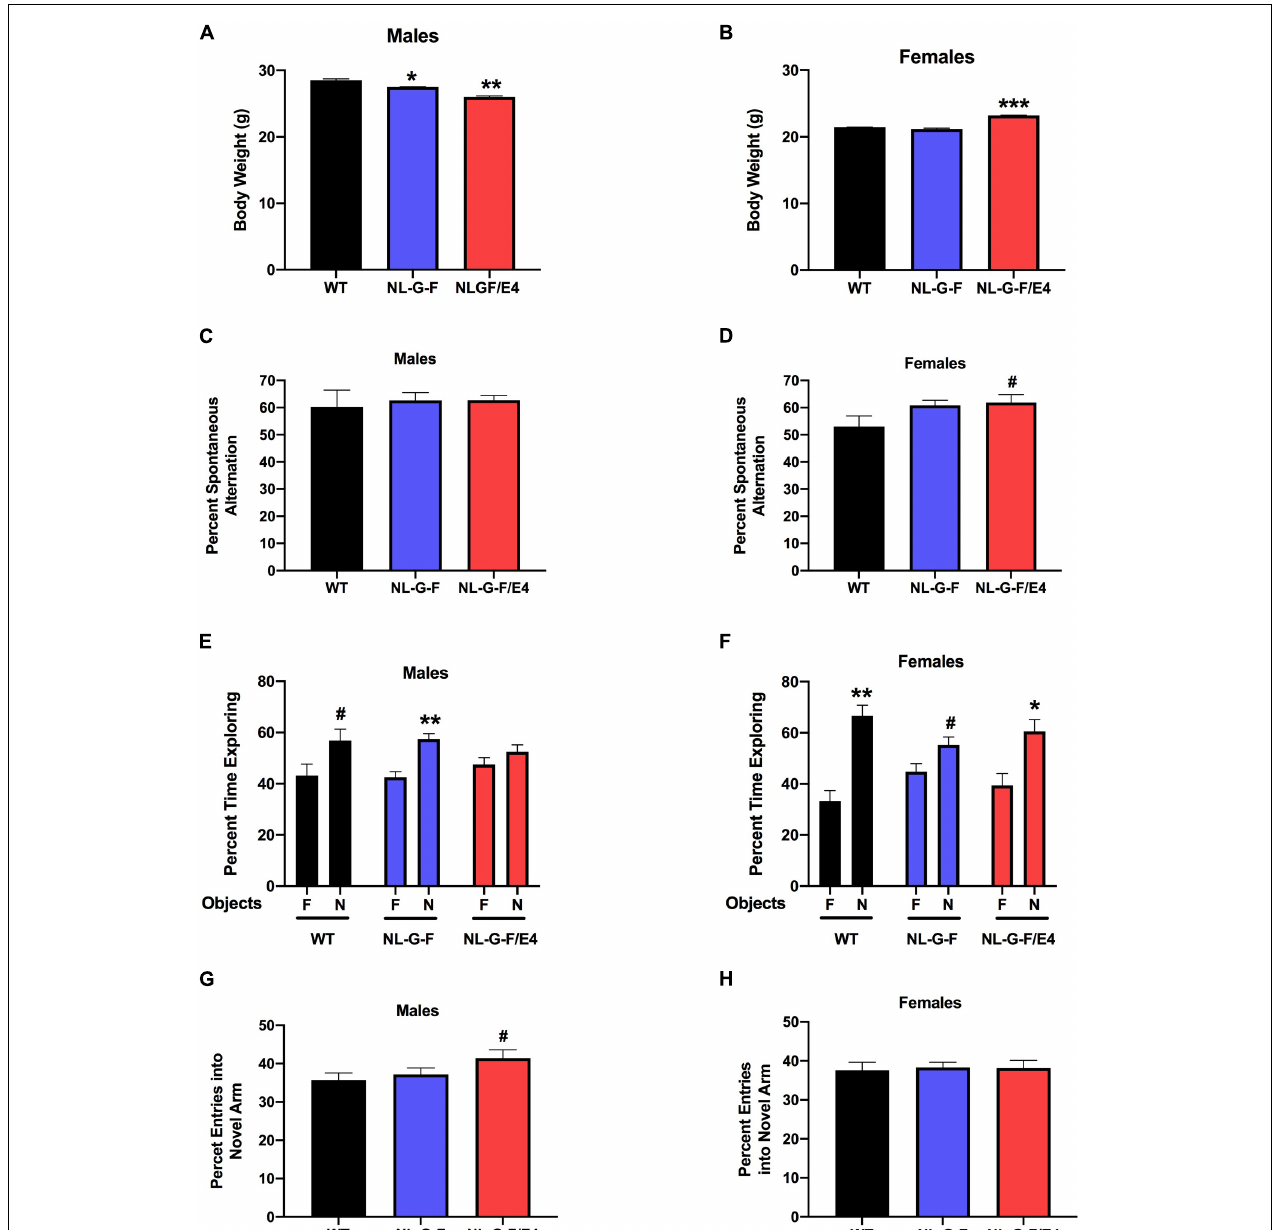
FIGURE 1 | (A) In recipient mice, there was an effect of genotype on body weights of males ( F (2,27) = 96.50, p = 0.0022). App NL − G − F and App NL − G − F / E4 , males were lighter than WT males. * p = 0.0219; ** p = 0.0016. (B) In recipient mice, there was an effect of genotype on body weights of females ( F (2,27) = 179.5, p = 0.0008). App NL − G − F / E4 females were heavier than WT females. *** p = 0.0010, Dunnett’s). (C) There was no effect of genotype on spontaneous alternation in male recipient mice. (D) There was a trend toward a higher percent spontaneous alternation in App NL − G − F / E4 than WT females. # p = 0.09, Dunnett’s. (E) There was a trend toward preferential exploration of the novel object in WT males, preferential exploration of the novel object in App NL − G − F / E4 males, but App NL − G − F males